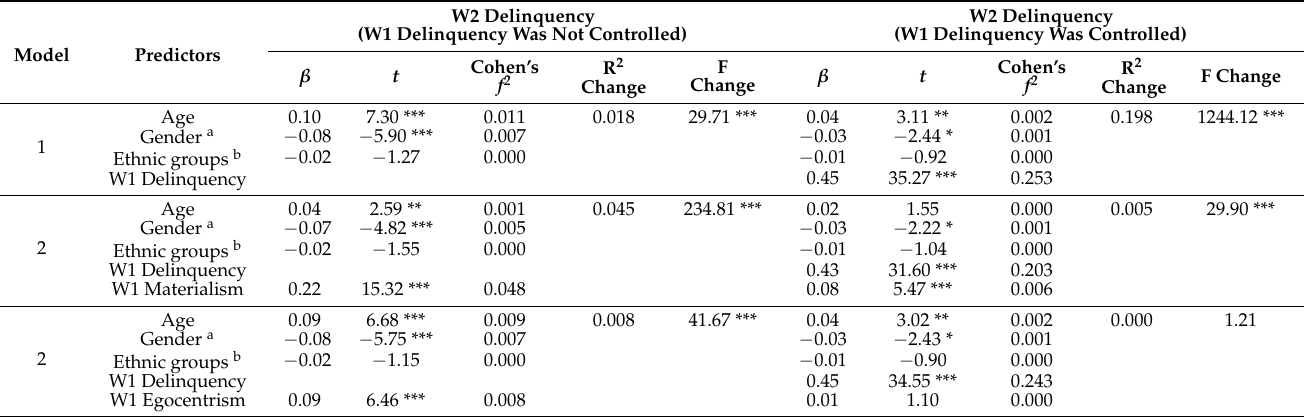
Table 5. Longitudinal regression analyses for delinquency.